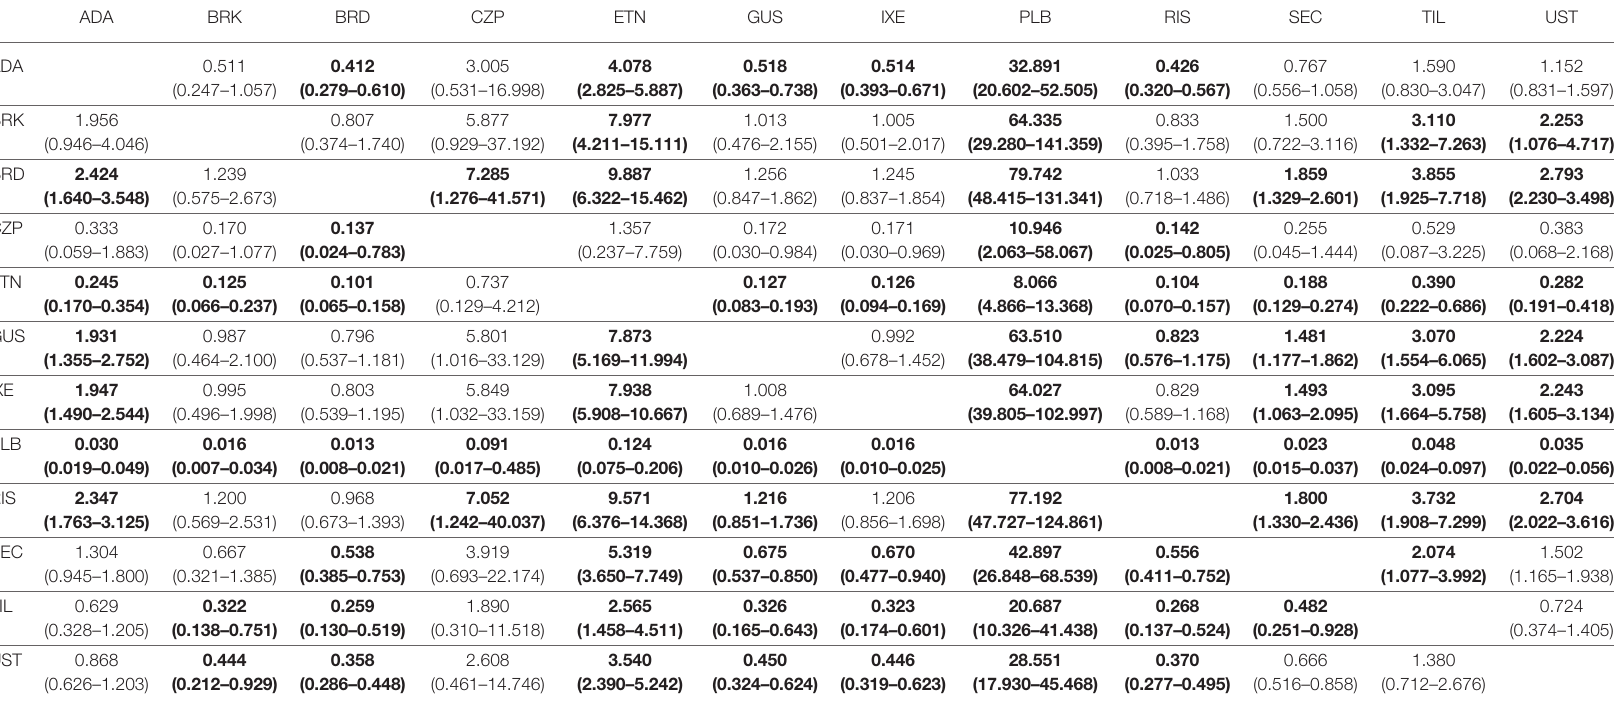
TABLE 8 | NMA results from the network of biologic therapies in the outcome